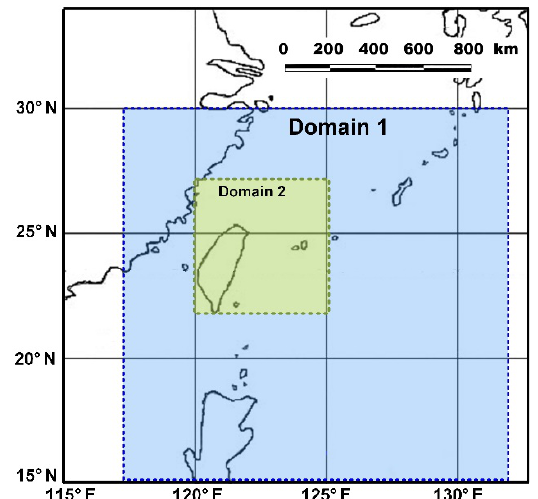
Figure 7. Nesting domain (Domains 1 and 2) of the WRF